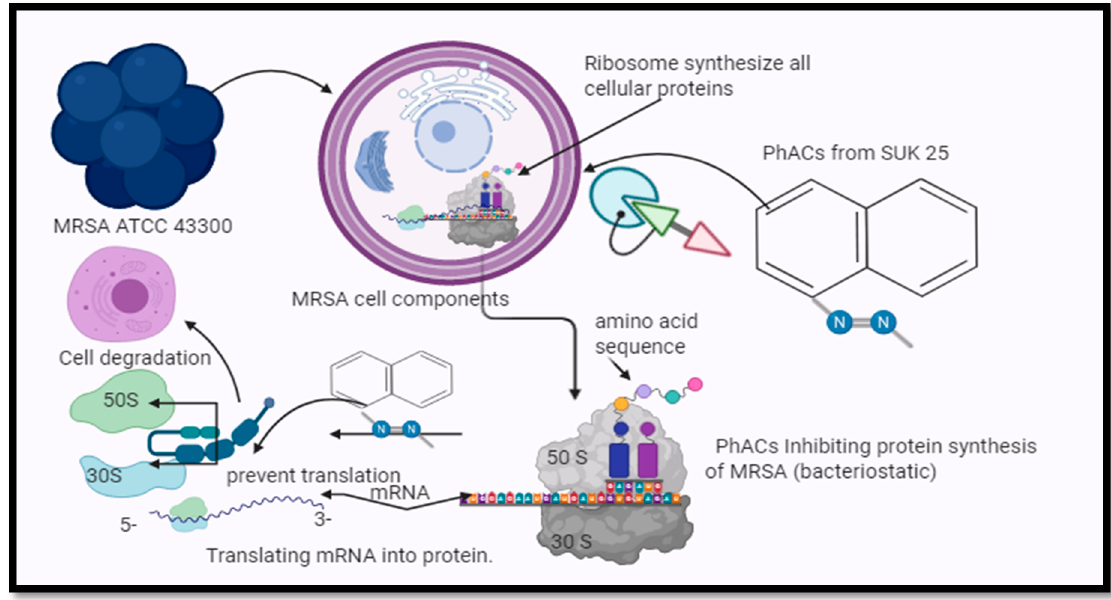
Figure 5. The mode of action of PhACs from SUK 25 against MRSA ATCC 43300. PhACs from SUK 25 stop the translation process and prevent the cell to converts genetic information carried in an mRNA molecule. Table 4. The fixed capital estimate (FCE) for production of PhACs by the SUK 25 using the submerged fermentation process.